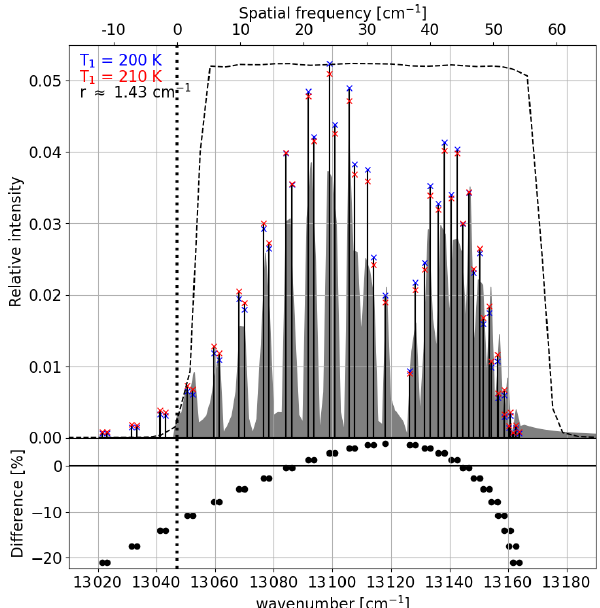
Figure 6. Modeled O 2 A band seen by the SHI instrument for tem- perature at 200 and 210K. The spectra are presented by the Dirac impulses such that the sum over all emission lines is equal to 1; below the relative intensity difference between the spectrum at 200 and 210K is shown. The dashed line shows the theoretical filter curve and the dotted vertical line the designed Littrow wavenumber of the AtmoLITE instrument. The gray shaded area shows the spec- trum convolved by the instrument line shape; r = 1.43cm − 1 is the spectral step